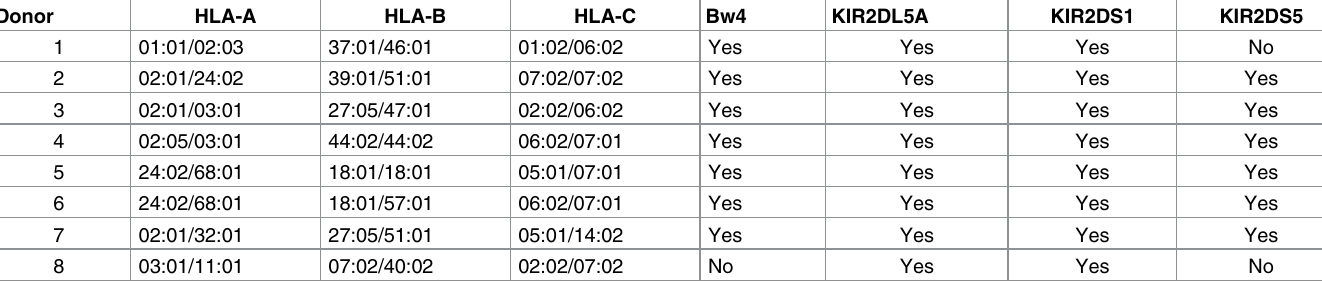
Table 1. KIR/HLA information on KIR3DS1homozygotes providing cells for functional studies. Donor